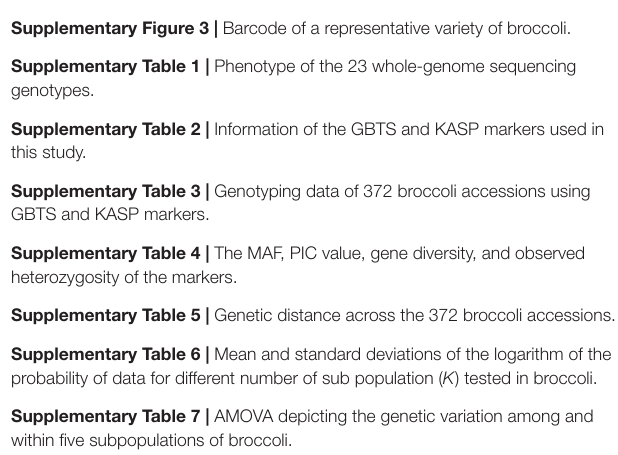
Supplementary Figure 1 | Bar plot of the STRUCTURE result. Supplementary Figure 2 | Percentage of molecular variance in the population. Supplementary Figure 3 | Barcode of a representative variety of broccoli. Supplementary Table 1 | Phenotype of the 23 whole-genome sequencing genotypes. Supplementary Table 2 | Information of the GBTS and KASP markers used in this study.